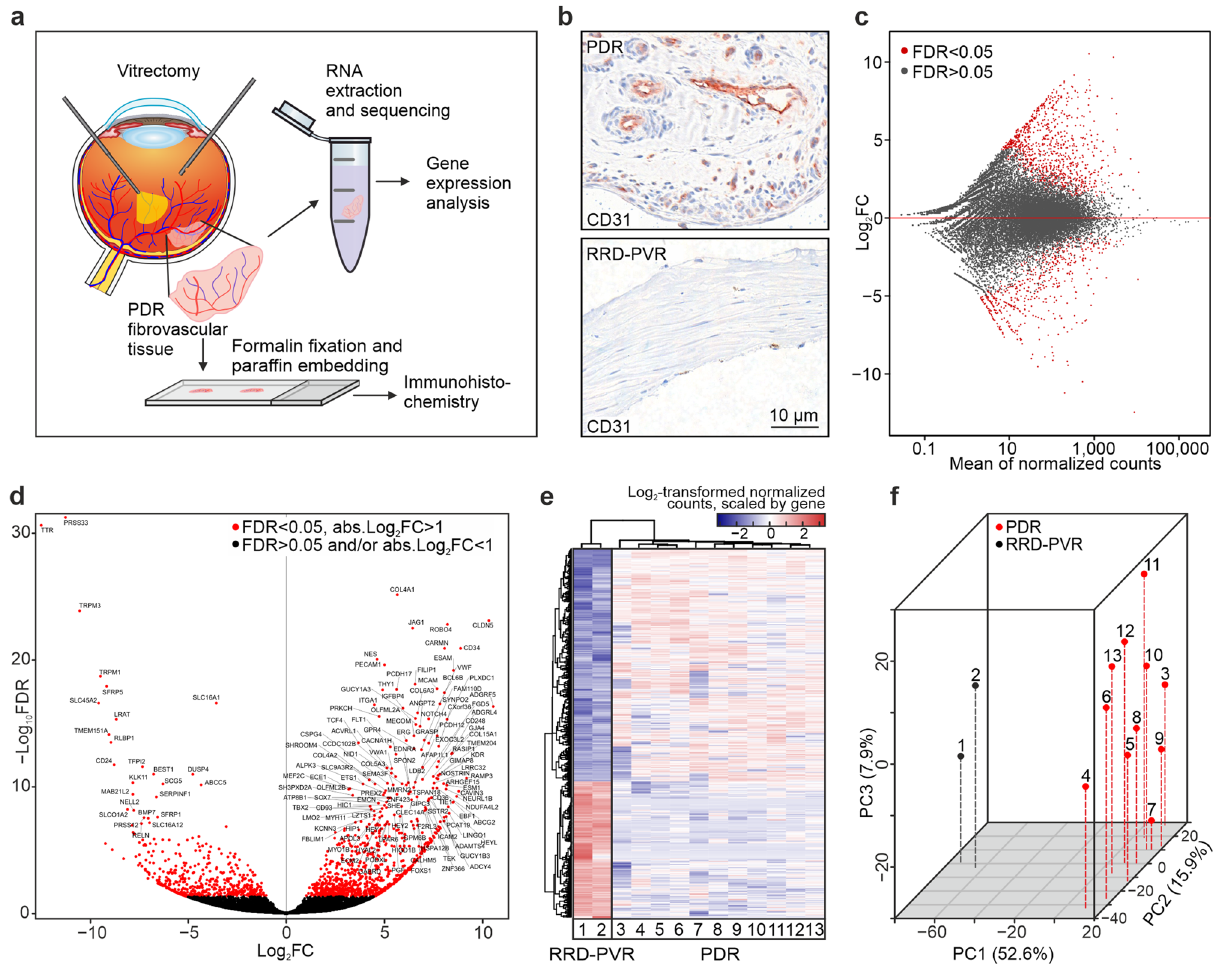
Figure 1. Overview of RNA-sequencing. ( a ) Schematic workflow: the PDR and RRD-PVR tissues were removed during vitrectomy. Excised tissues were either placed in RNA-later, processed for sequencing and sequenced; or formalin fixed, paraffin embedded (FFPE) and cut into sections for immunostaining. From sequencing data, differentially expressed genes (DEGs) were identified, and enrichment analysis was performed to identify overrepresented pathways, molecular functions, biological processes, and cellular components. ( b ) Representative light micrographs of immunohistochemistry for CD31 visualizes endothelial vascular structures in PDR and absence of vasculature in RRD-PVR tissue. Scale bar, 10 µm. ( c ) MA-plot of log 2 - fold change and mean normalized count for all genes. Each gene is represented by a grey dot. Differentially expressed genes (DEGs) are indicated in red. ( d ) Volcano plot of gene expression. ( e ) Heatmap representing color-coded expression levels of differentially expressed genes. Hierarchical clustering analysis performed using log-transformed normalized read counts of DEGs (FDR-corrected p value < 0.05, absolute log 2 fold change > 1) between RRD-PVR patients (n = 2) and PDR patients (n = 11), showing interpatient variability. ( f ) 3D principal component analysis (PCA) plot with PDR (red) and RRD-PVR (black) samples plotted in three dimensions using their projection onto the first three principal components (PC1, PC2, PC3). Each dot represents a patient. Principal component analysis was performed using the 500 most variable genes. PC1, PC2 and PC3 explained 52.6%, 15.9% and 7.9% of the variation, respectively. The PDR samples clearly segregated from the RRD-PVR group along PC1 and showed more variability on PC2 and